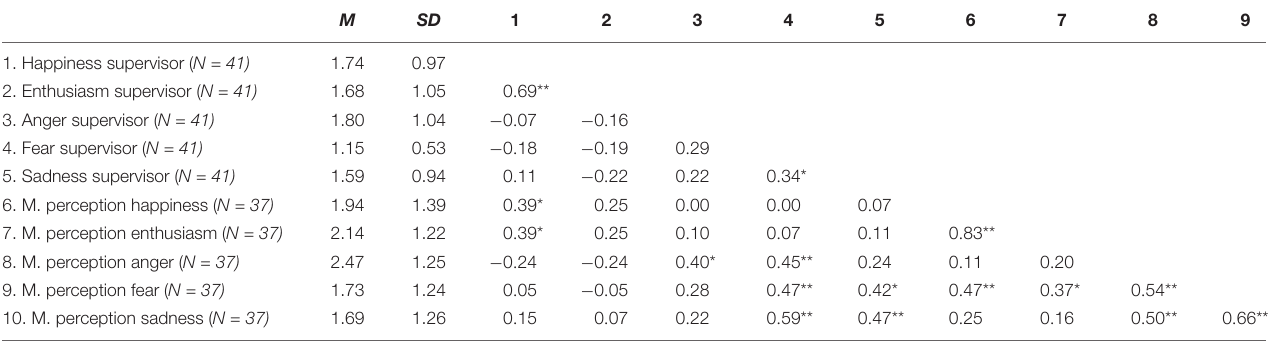
FIGURE 1 | Hierarchical position, experience of emotion, and mediators’ perceptions of emotion. TABLE 2 | Means (M), standard deviations (SD), and correlations between supervisors’ emotions happiness, enthusiasm, anger, fear, sadness and mediator emotion perception. M